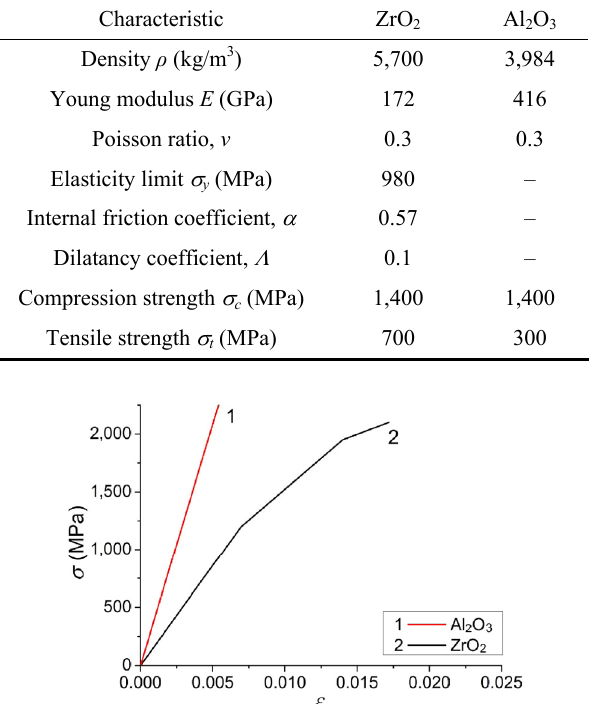
Table 1 Mechanical characteristics of the materials modeled.